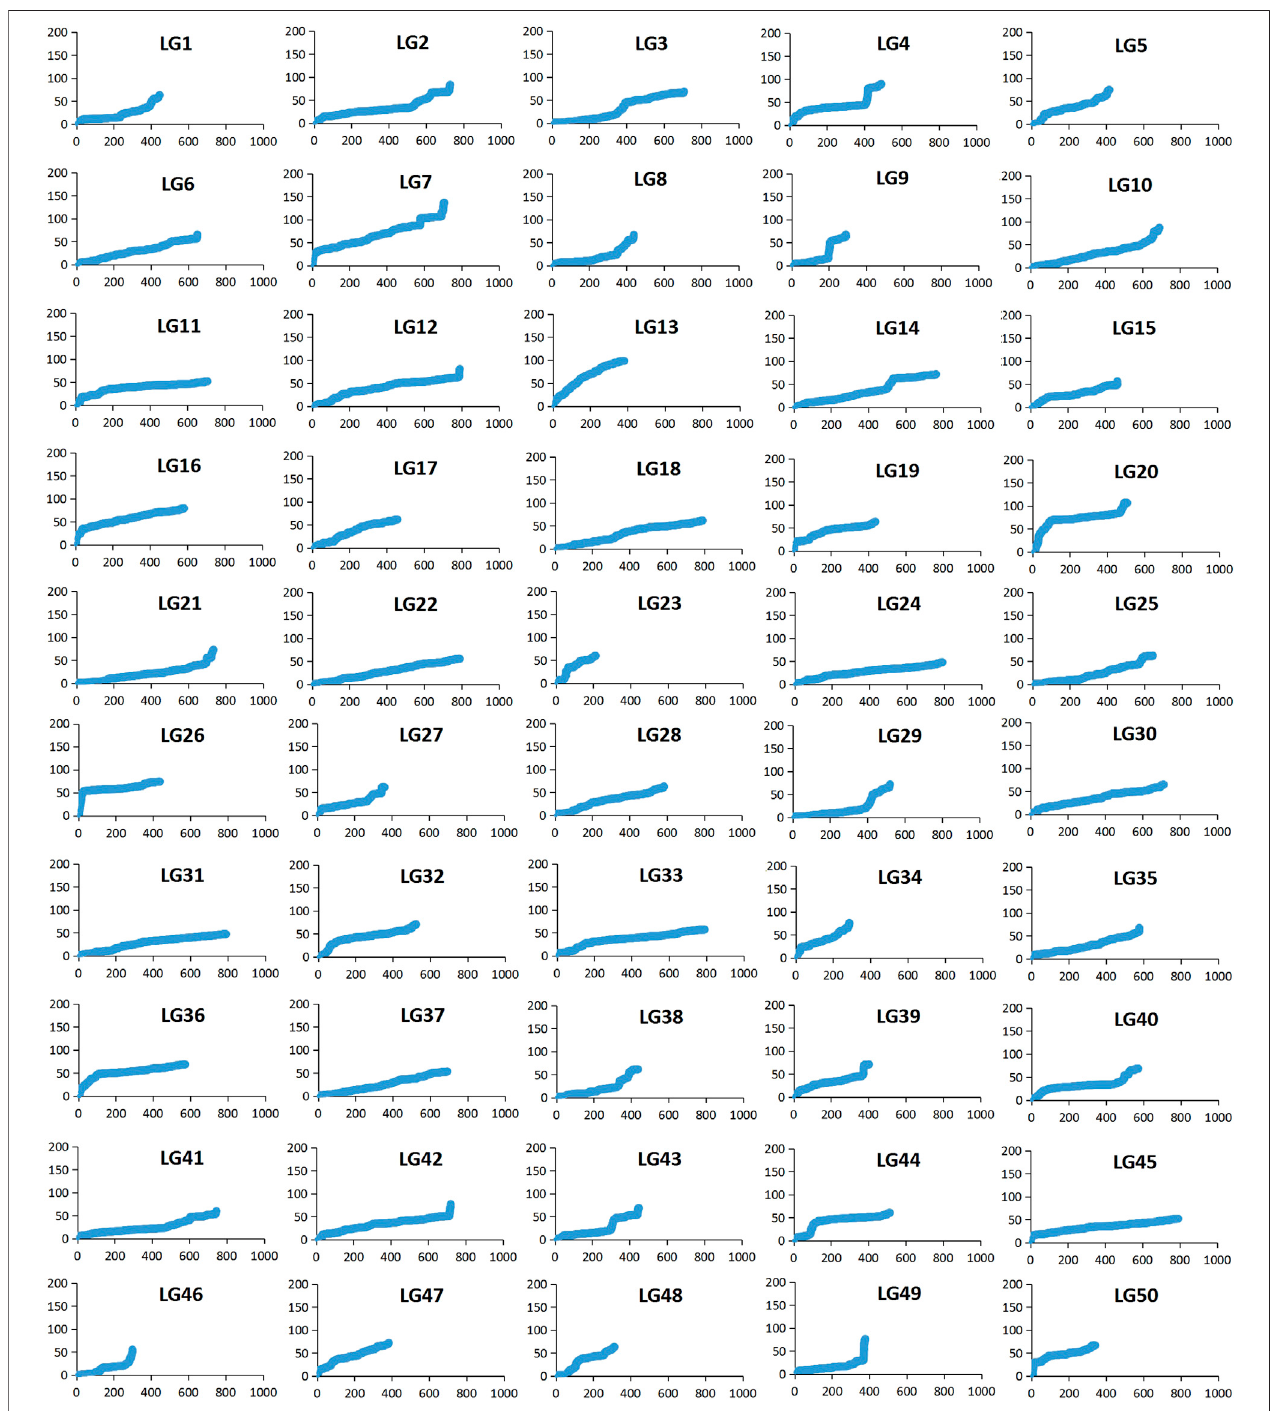
FIGURE 2 | The patterns of marker distribution on each linkage group. The X-axis represents marker orders on each linkage group. The Y-axis represents SNP marker position (cM) or each linkage group.